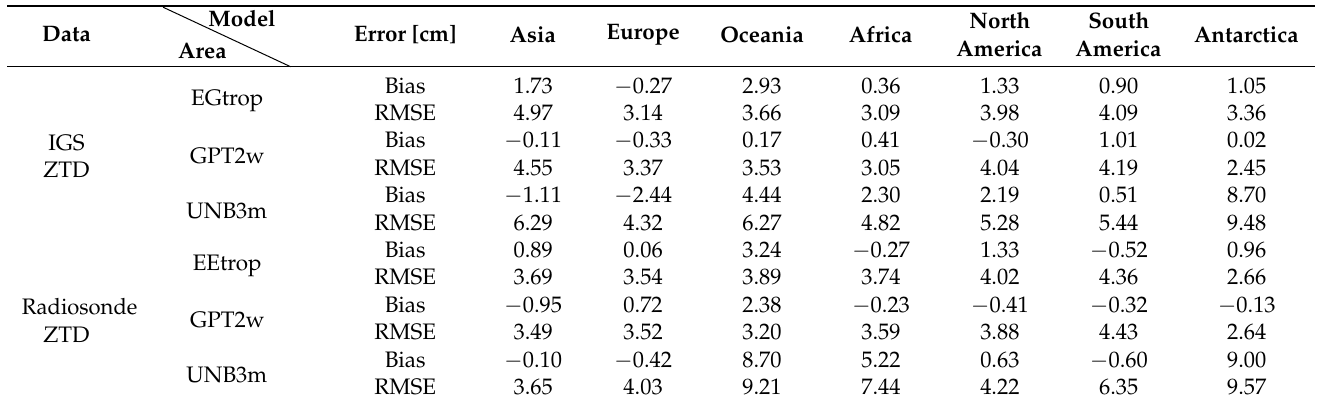
Table 4. Error statistics of the tropospheric delay models compared to the ZTD derived from IGS and Radiosonde. Data